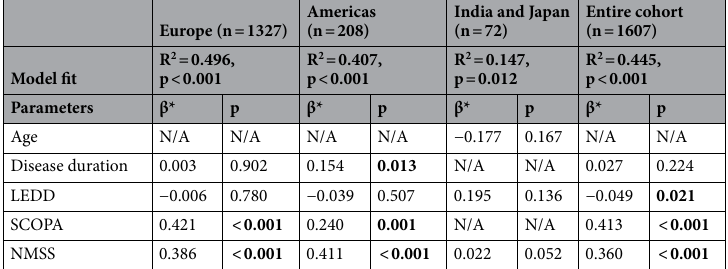
Table 3. Regression model with predictors of quality of life, as measured by the PDQ-8 scale. LEDD levodopa equivalent daily dose, SCOPA Scales for Outcomes in Parkinson’s disease, NMSS Non Motor Symptoms Scale, N/A not applicable (factor not associated with PDQ-8 scores in a univariate model), β* standardised β. Only variables which were significantly associated with PDQ-8 scores in a univariate model were included in the respective analyses. P-values in bold are significant (p ≤ 0.05).